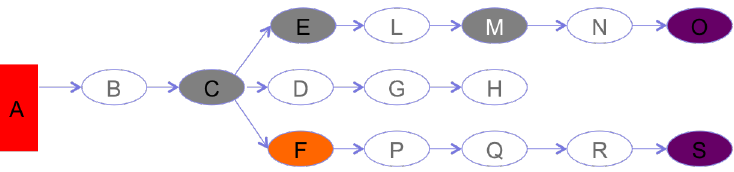
Figure 7. The RecSim electrical model.